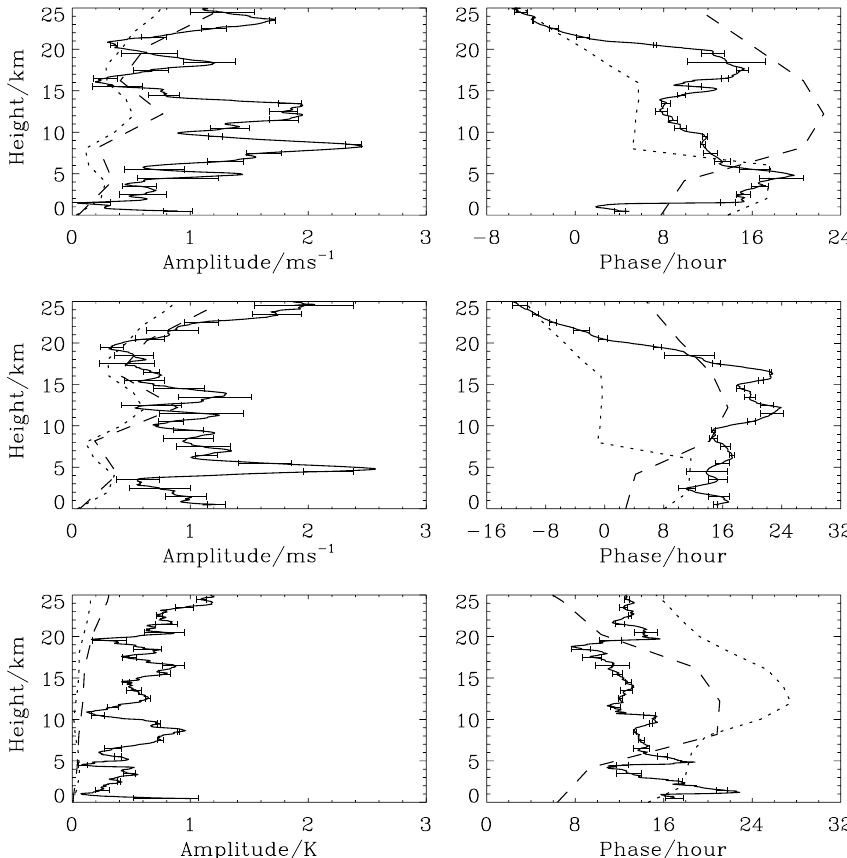
Fig. 7. Similar to Fig. 6, but in January